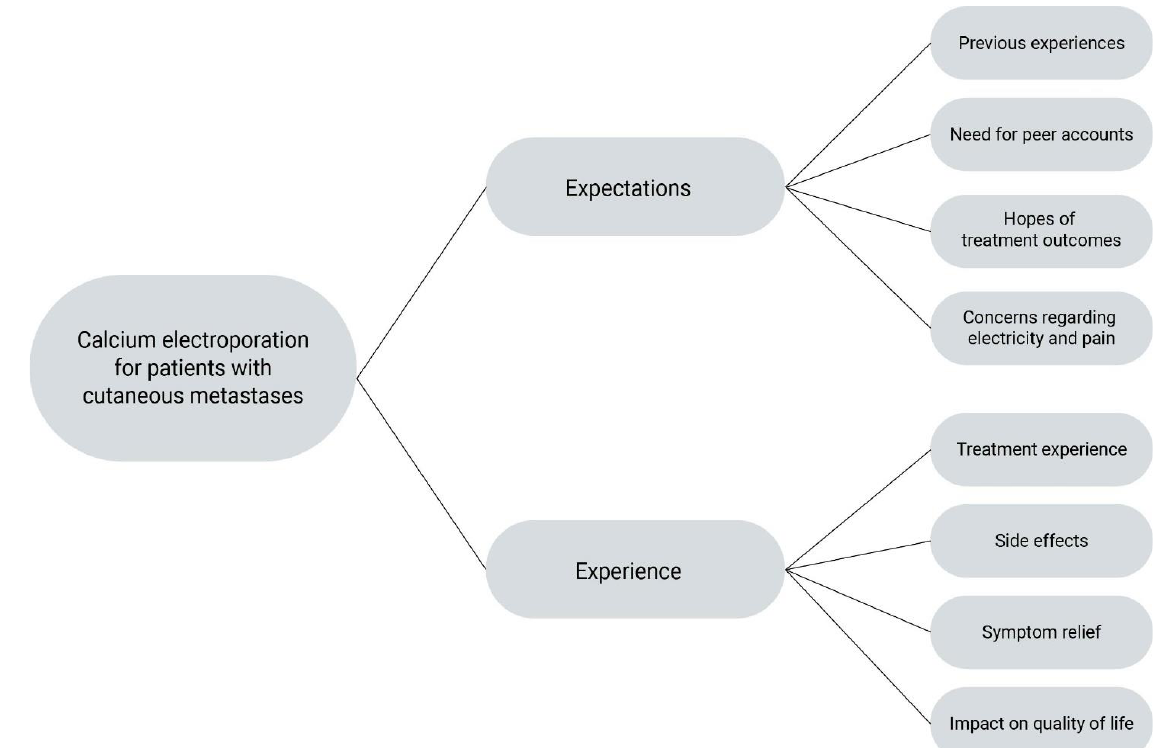
Figure 1. Themes and subthemes.